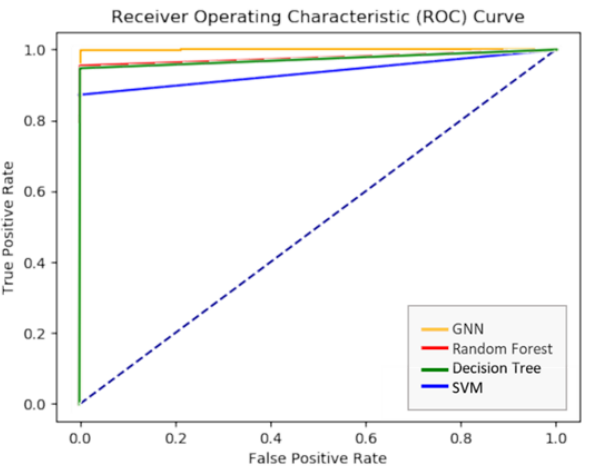
Figure 6. Detection efficiency against the denial-of-service attack with all devices online.